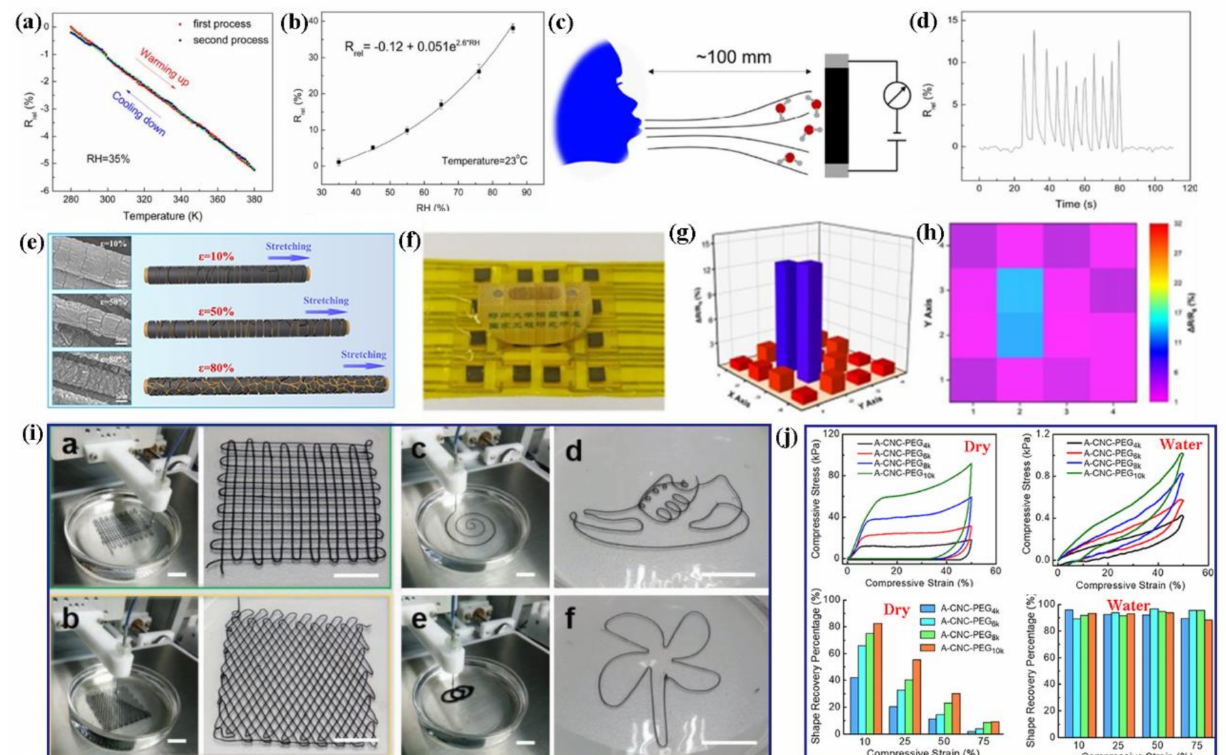
Figure 9. ( a , b ) Sensitivity of rGO/cellulose composite to temperature and humidity, ( c ) schematic for in-situ monitor- ing electrical resistance changes of rGO/cellulose composite film placed at a distance up to 100 mm from one’s nose, ( d ) dependence of R rel on time for in-situ monitoring human breathing cycles of inhalation and exhalation. Reproduced with permission from [83]. Copyright 2018, Royal Society of Chemistry; ( e ) In-situ SEM images and the corresponding schematic illustration for the microstructure change of the strain sensor during the tension process, ( f – h ) photographs of different items onto the e-skin and the corresponding spatial pressure distribution mapping based on the resistance variation. Reproduced with permission from [84]. Copyright 2020, Royal Society of Chemistry; ( i ) optical images of the 3D-printed TOCNFs/Ti 3 C 2 fabrics with woodpile, fishing net structures and other designed geometric structures. Reproduced